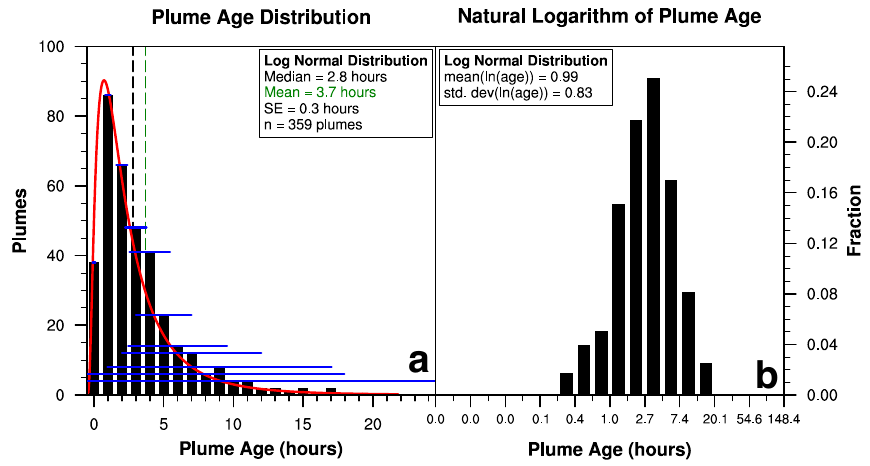
Fig. 10. (a) Histogram of plume age, with a lognormal plume age PDF superimposed. Error bars extend along the x -axis (plume age) rather than along the y -axis (plume count). (b) Histogram of the natural logarithm of (a)